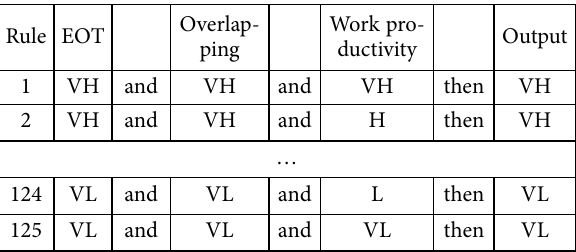
Table 2. Fuzzy inference rules applied with EOT, overlapping,